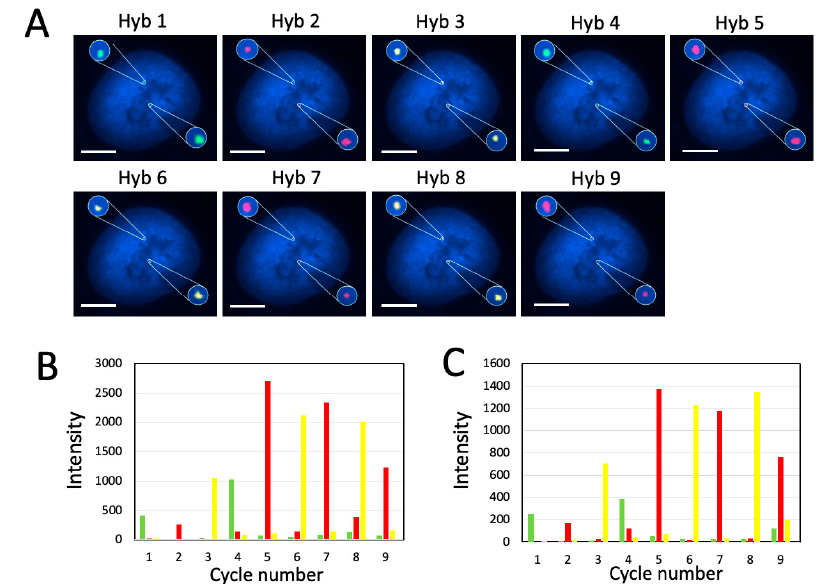
Figure 5. ( A ) Genomic locus 4p16.1 in HeLa cells ( n = 30 cells) are detected in 9 cycles of C-FISH. Alexa 488 labeled decoding probes were used in the 1st and 4th cycles. Cy5 labeled decoding probes were used in the 2nd, 5th, 7th and 9th cycles. Quasar 570 labeled decoding probes were used in the 3rd, 6th and 8th cycles. ( B ) Signal intensity profiles of the upper spot in (A). ( C ) Signal intensity profiles of the lower spot in (A). The signal intensities in Alexa 488, Quasar 570, and Cy5 channels are shown in green, yellow and red, respectively. Scale bars, 5 µm.